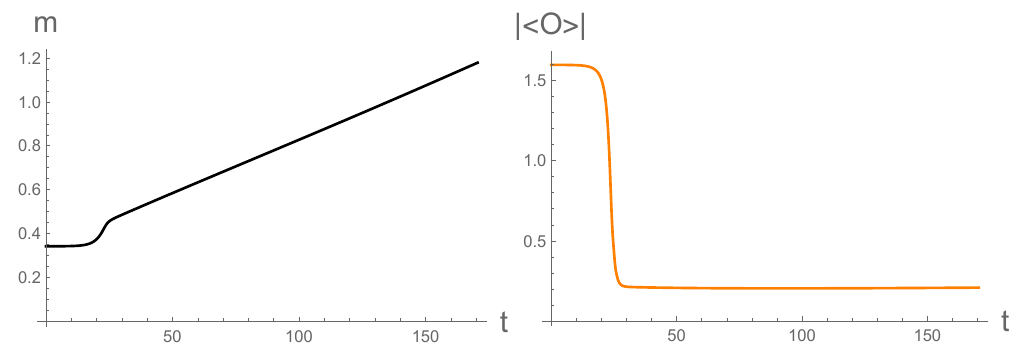
Figure 25 . Time evolution of the energy density (left) and vev modulus (right) of the SPS with (cid:26) b = 0 : 01 ; ! b = 2 : 375 when perturbed by its fundamental, unstable eigenmode with amplitude (cid:15) = 0 :